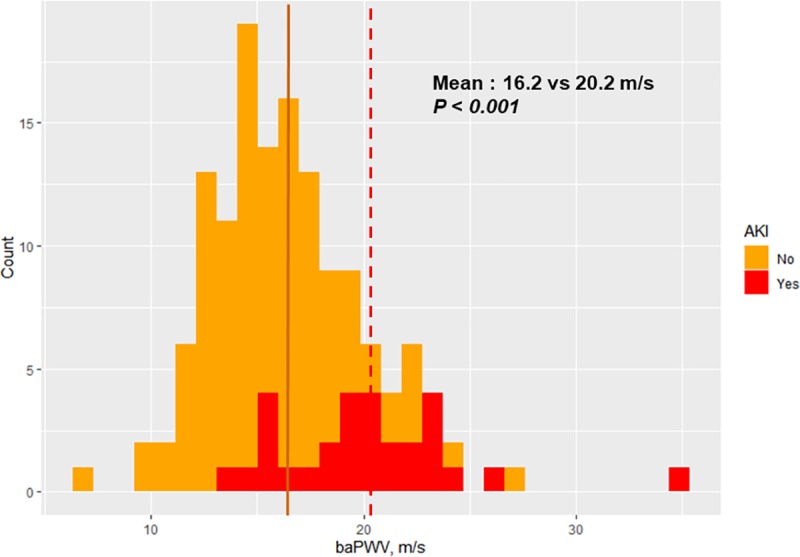
Comparison of distributions of baPWV data between patients with and without acute kidney injury.Solid line = mean baPWV of patients without AKI, dotted line = mean baPWV of patients with AKI. AKI, acute kidney injury; baPWV, brachial-ankle pulse wave velocity.